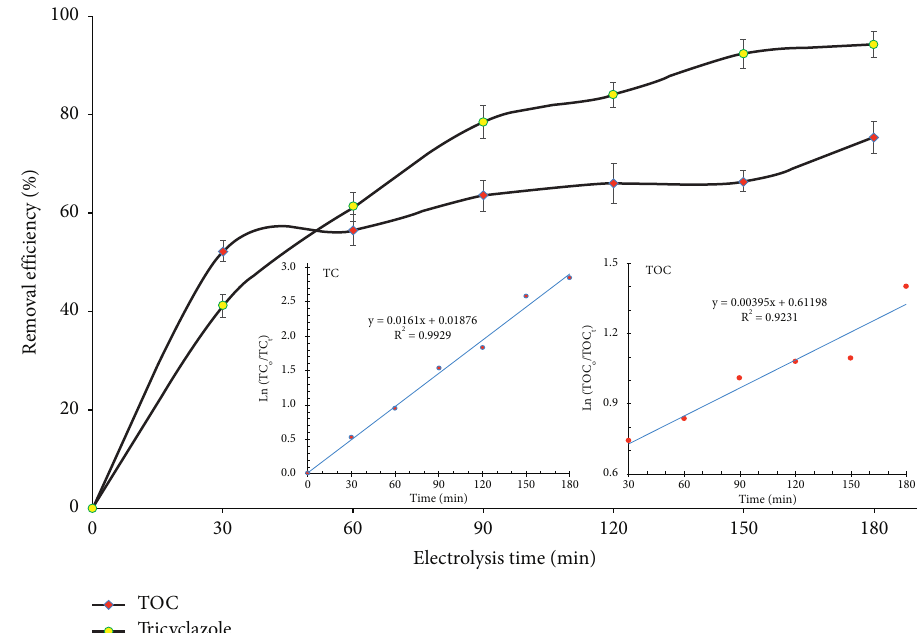
Figure 2: Effect of different electrolysis time points and reaction kinetic orders on TC and TOC removal with a current density of 2.22mA/ cm 2 and 0.2mM Fe 2+ dosage.